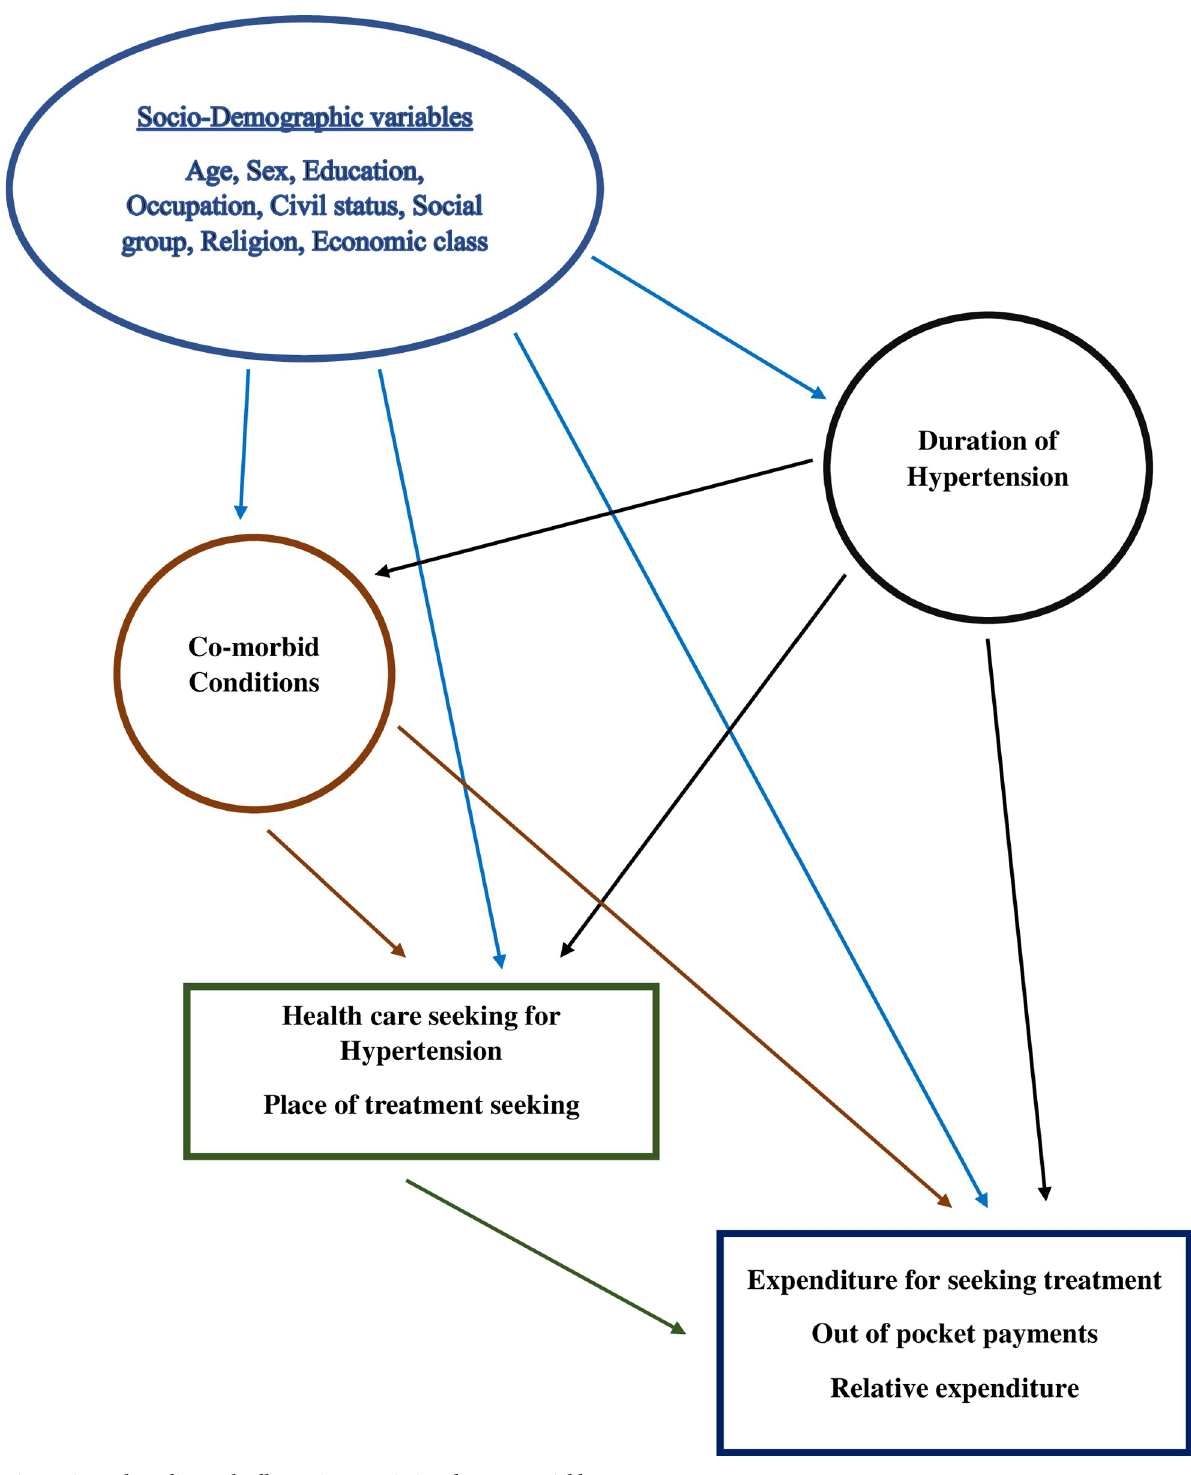
Fig 2. Directed acyclic graph: Illustrating associations between variables.